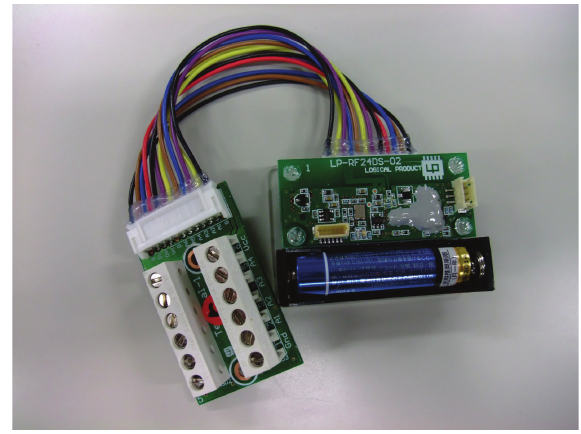
Figure 11: Appearance of WHM-4.